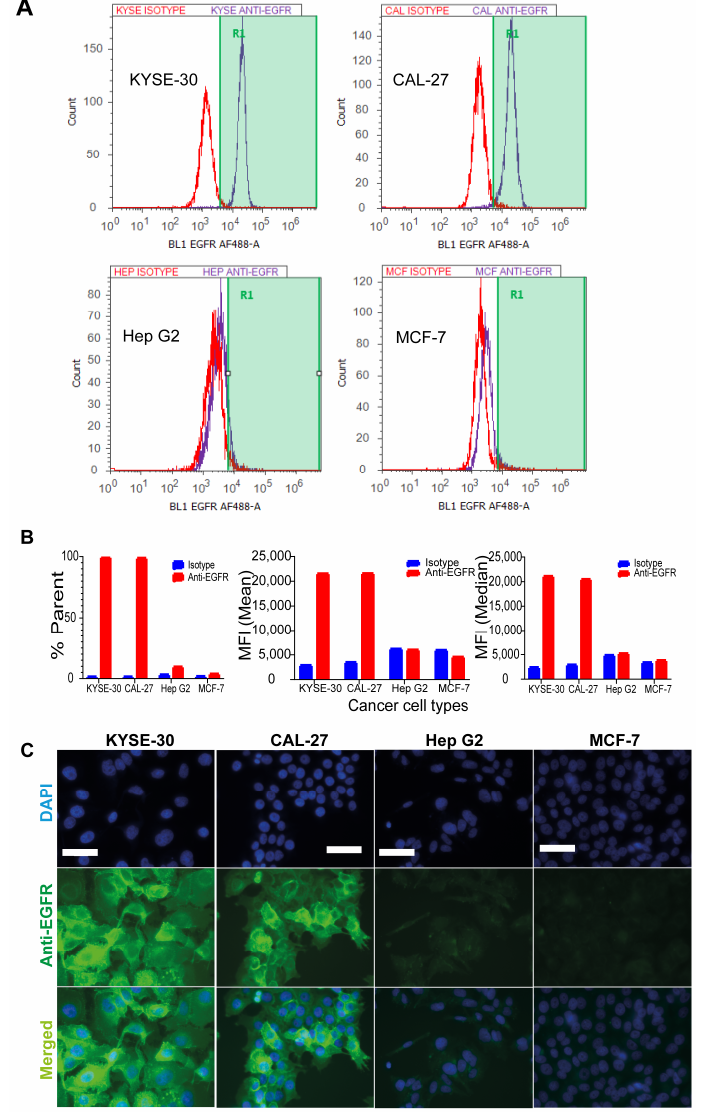
Figure 2. CAL-27 and KYSE-30 cancer cells express high level of EGFR. ( A ) Flow cytometry (red, isotype and blue, anti-EGFR staining); EGFR-positive cancer cell lines KYSE-30 and CAL-27 had an 8.7 and 7-fold increase in fluorescence in the presence of anti-EGFR antibody, respectively, while EGFR-negative cancer cell lines Hep G2 and MCF-7 showed no such increase. The y -axis represents the number of events (counts) and the x -axis represents the fluorescence signal intensity from the EGFR-bound antibody. ( B ) Quantification of flow cytometry results as a percentage of total cells (% parent), mean and median fluorescence intensity of both isotype and anti-EGFR antibodies in 4 different cancer cell types. ( C ) Immunofluorescence staining of these four cancer cell lines using anti-EGFR and isotype antibodies showed a high expression of EGFR in KYSE-30 and CAL-27 compared with Hep G2 and MCF-7 cancer cell lines. Scale bars, 50 µ